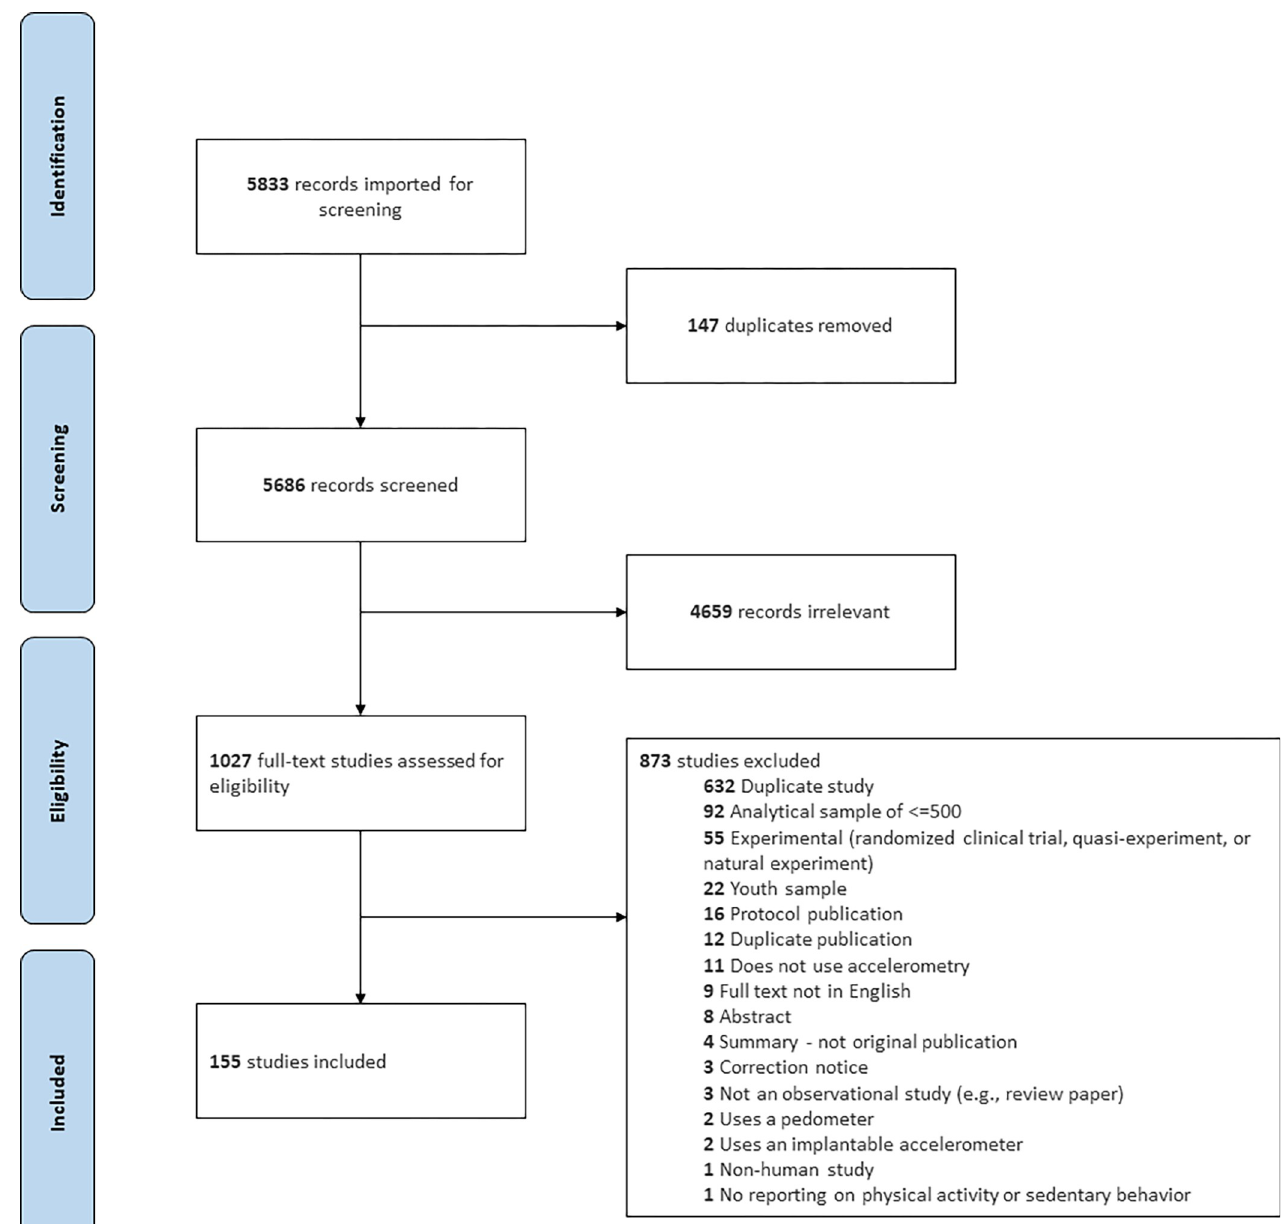
Fig 1. PRISMA chart displaying the identification, screening, eligibility and inclusion for each study reviewed. In total, 155 studies were included from 154 publications. One publication included two studies (Dutch Longitudinal Internet Studies for Social Sciences and Understanding America Study) that were not mentioned in other identified